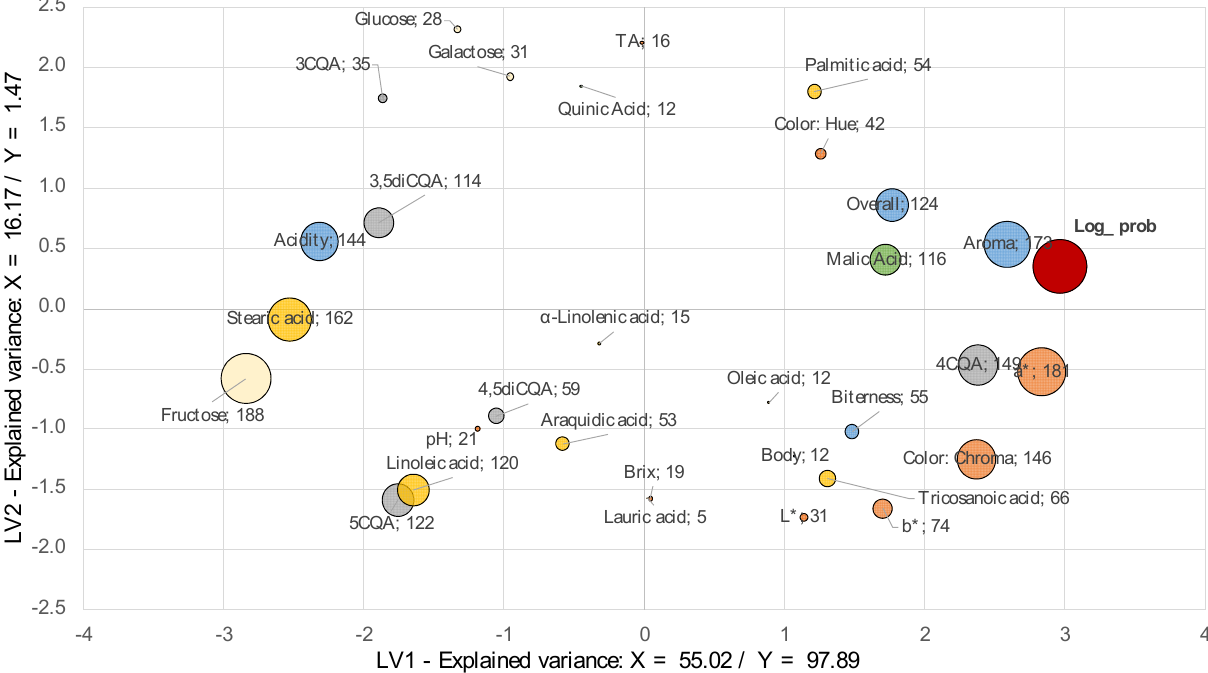
Figure 5. Loadings plot for SD concentrate samples, storage during 12 months at 25 ◦ C by bootstrapped—feature selection version of PLS analysis. Color depicts feature type: red—log-acceptability ratio, blue—sensory, gray—CQAs, yellow: organic acids and orange—physicochemical; bubble size represents variable relevance.